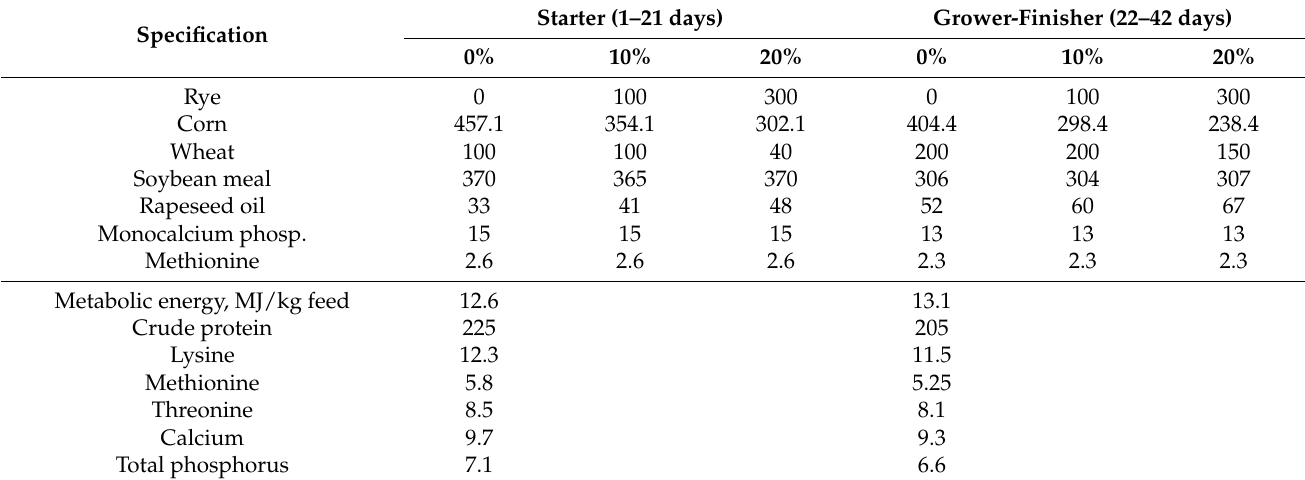
Table 4. Composition and nutrient content of experimental diets for chicken broilers fed different doses of hybrid rye in diet (g/kg dry